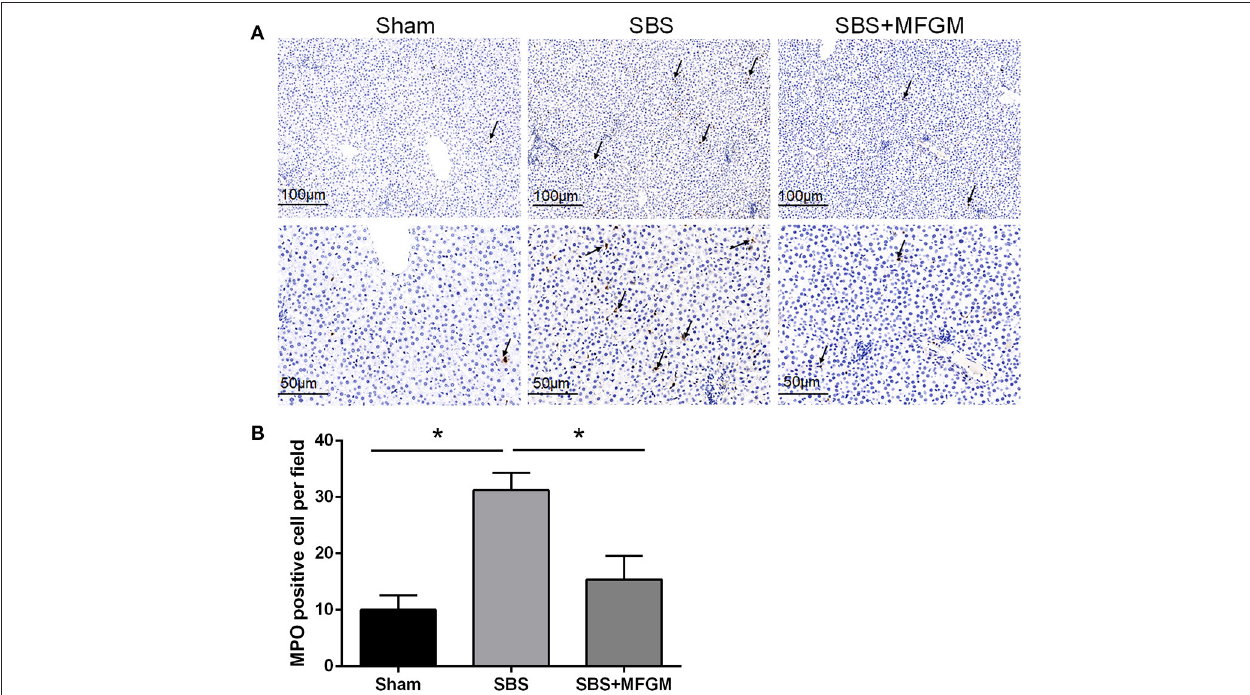
FIGURE 2 | Immunohistochemistry staining of MPO in the liver (A) ; The quantification of MPO positive cells in the liver (B) . Black arrows indicate MPO-positive cells. Data were presented as the means ± SD ( n = 5-7), group differences were determined by ANOVA test followed by Tukey’s post hoc test, and * P < 0.05 indicates a difference between the two groups. MPO, myeloperoxidase; MFGM, milk fat globule membrane; SBS, short bowel syndrome.